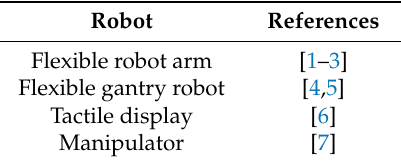
Table 1. Summary of state-of-the-art robotic applications using